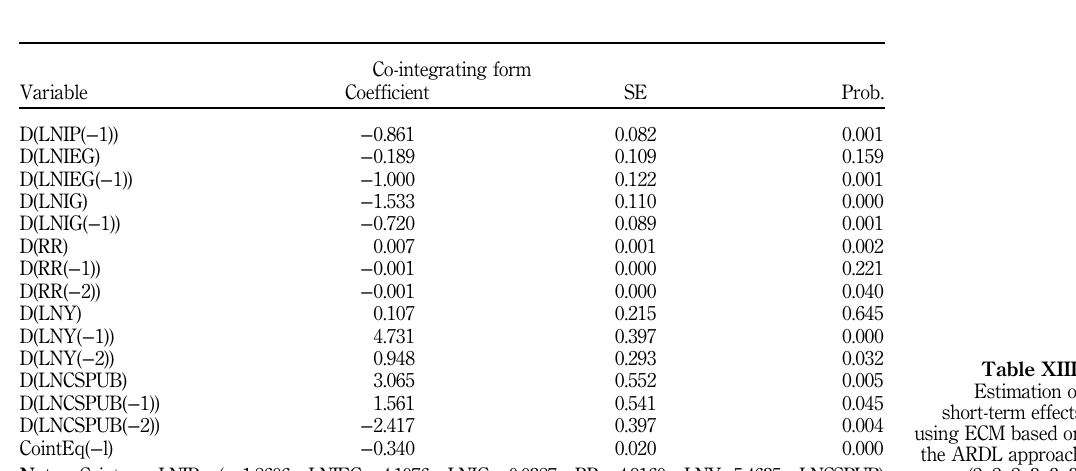
Table XIII. Estimation of short-term effects using ECM based on the ARDL approach (2, 2, 2, 3, 3,